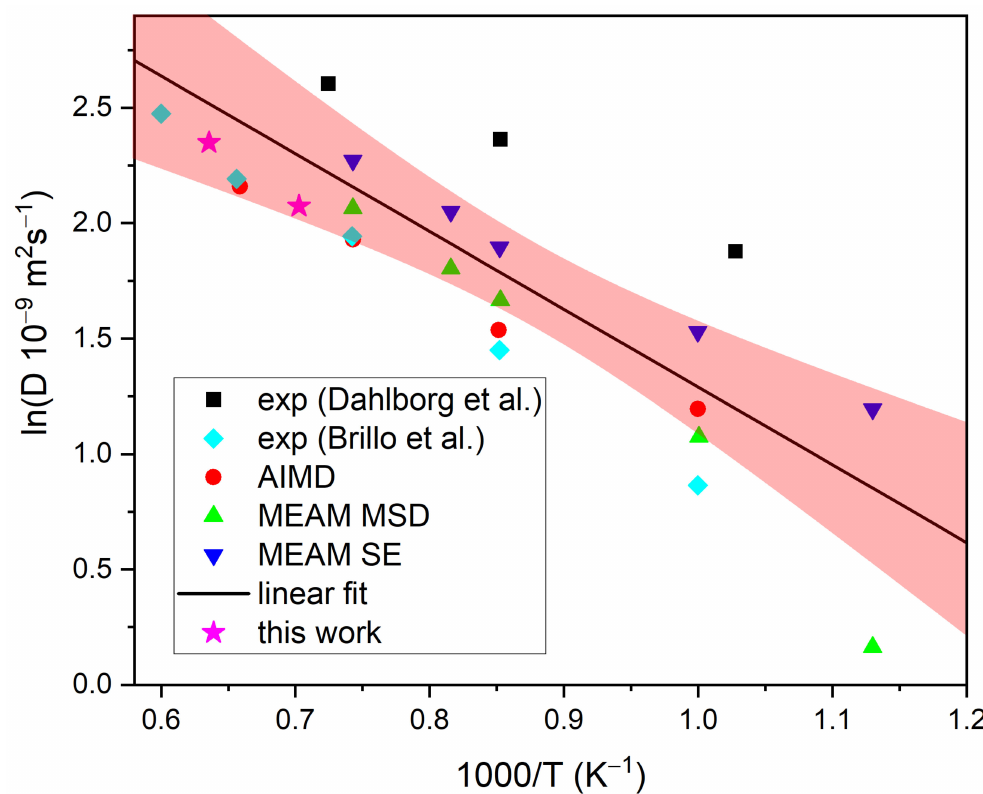
Figure 4. Arrhenius plot of the self-diffusivity of Cu in Al 80 -Cu 20 liquid alloy obtained by different methods [7,15,73,74] in comparison with our results (the red area restricts the 95% confidence interval of the linear